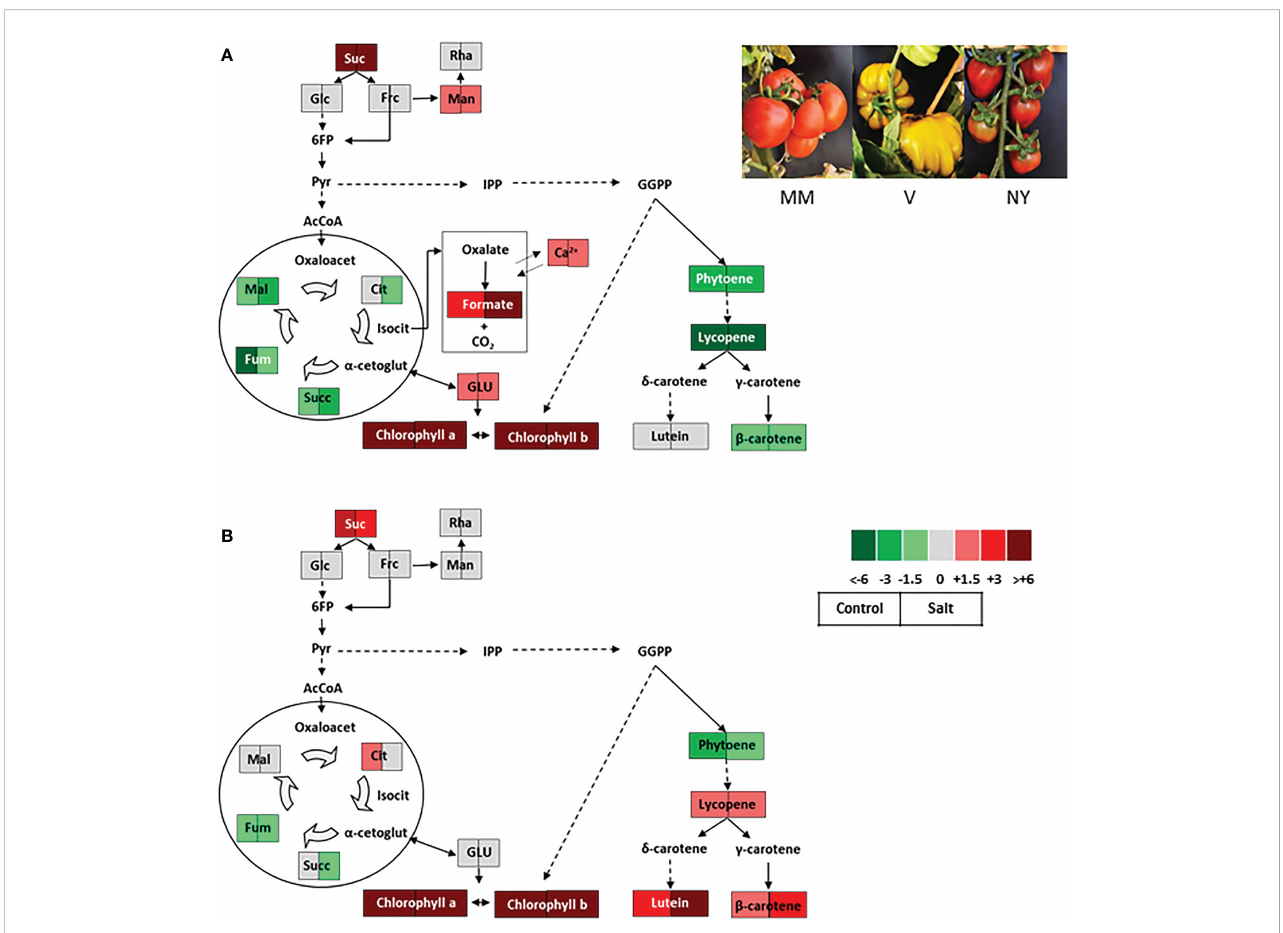
FIGURE 3 Contrasting metabolic pro fi les in ripe fruits of two traditional tomato varieties coming from the Spanish Southeast area and belonging to the RAERM collection. Schematic representations of the metabolic changes occurring in ripe fruits of varieties (A) Verdal (V) and (B) Negro Yeste (NY) from plants grown without stress (control) and with salt stress (100 mM NaCl during 70 days). Data were normalized to cv Moneymaker (MM). Color scale is used to display the different amount of metabolite in terms of fold-change relative to the level in the appropriate control. Suc, sucrose; Glc, glucose; Frc, fructose; Man, mannose; L-asc, L-ascorbic acid; 6FP, fructose-6-phosphate; Pyr, pyruvate; IPP, isopentenyl diphosphate; GGPP, geranylgeranyl diphosphate; AcCoA, acetylCoA; Oxaloacet, oxaloacetate; Cit, citrate; Isocit, isocitrate; a -cetoglut, a -cetoglutarate; Succ, succinate; Fum, fumarate; Mal, malate; GLU, glutamate. Adapted from Figures 7, 8 of Massaretto el al. 2018. Recovering tomato landraces to simultaneously improve fruit yield and nutritional quality against salt stress. Front. Plant Sci. 9:1778. doi: